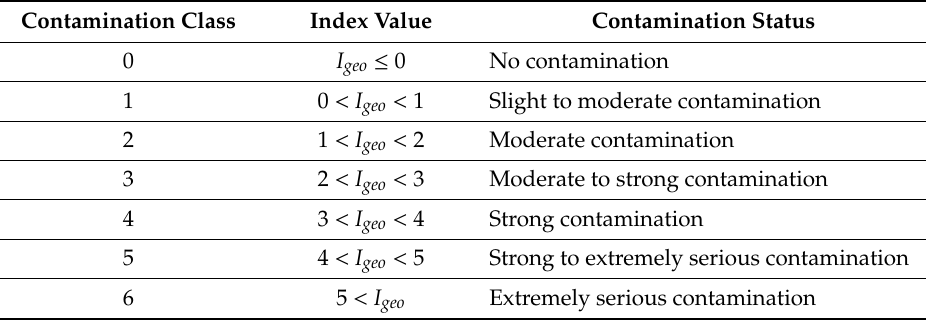
Table 2. Classification of geo-accumulation index and respective description.